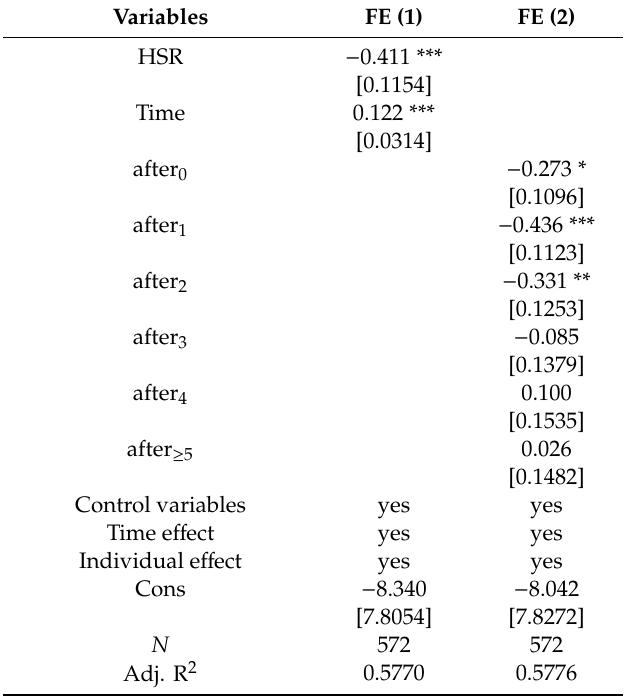
Table 11. Test of the direct and dynamic e ff ects of the HSR after